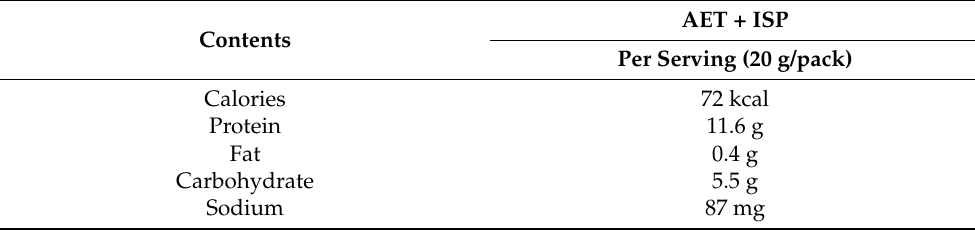
Table 1. Nutritional content of the ISP supplement (for the AET + ISP group).